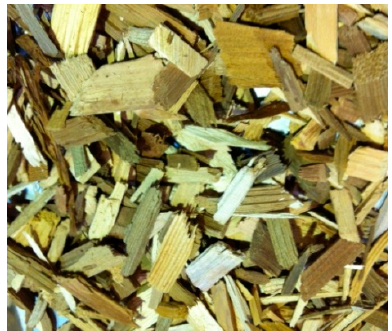
Figure 1. Western Red Cedar chips as received.